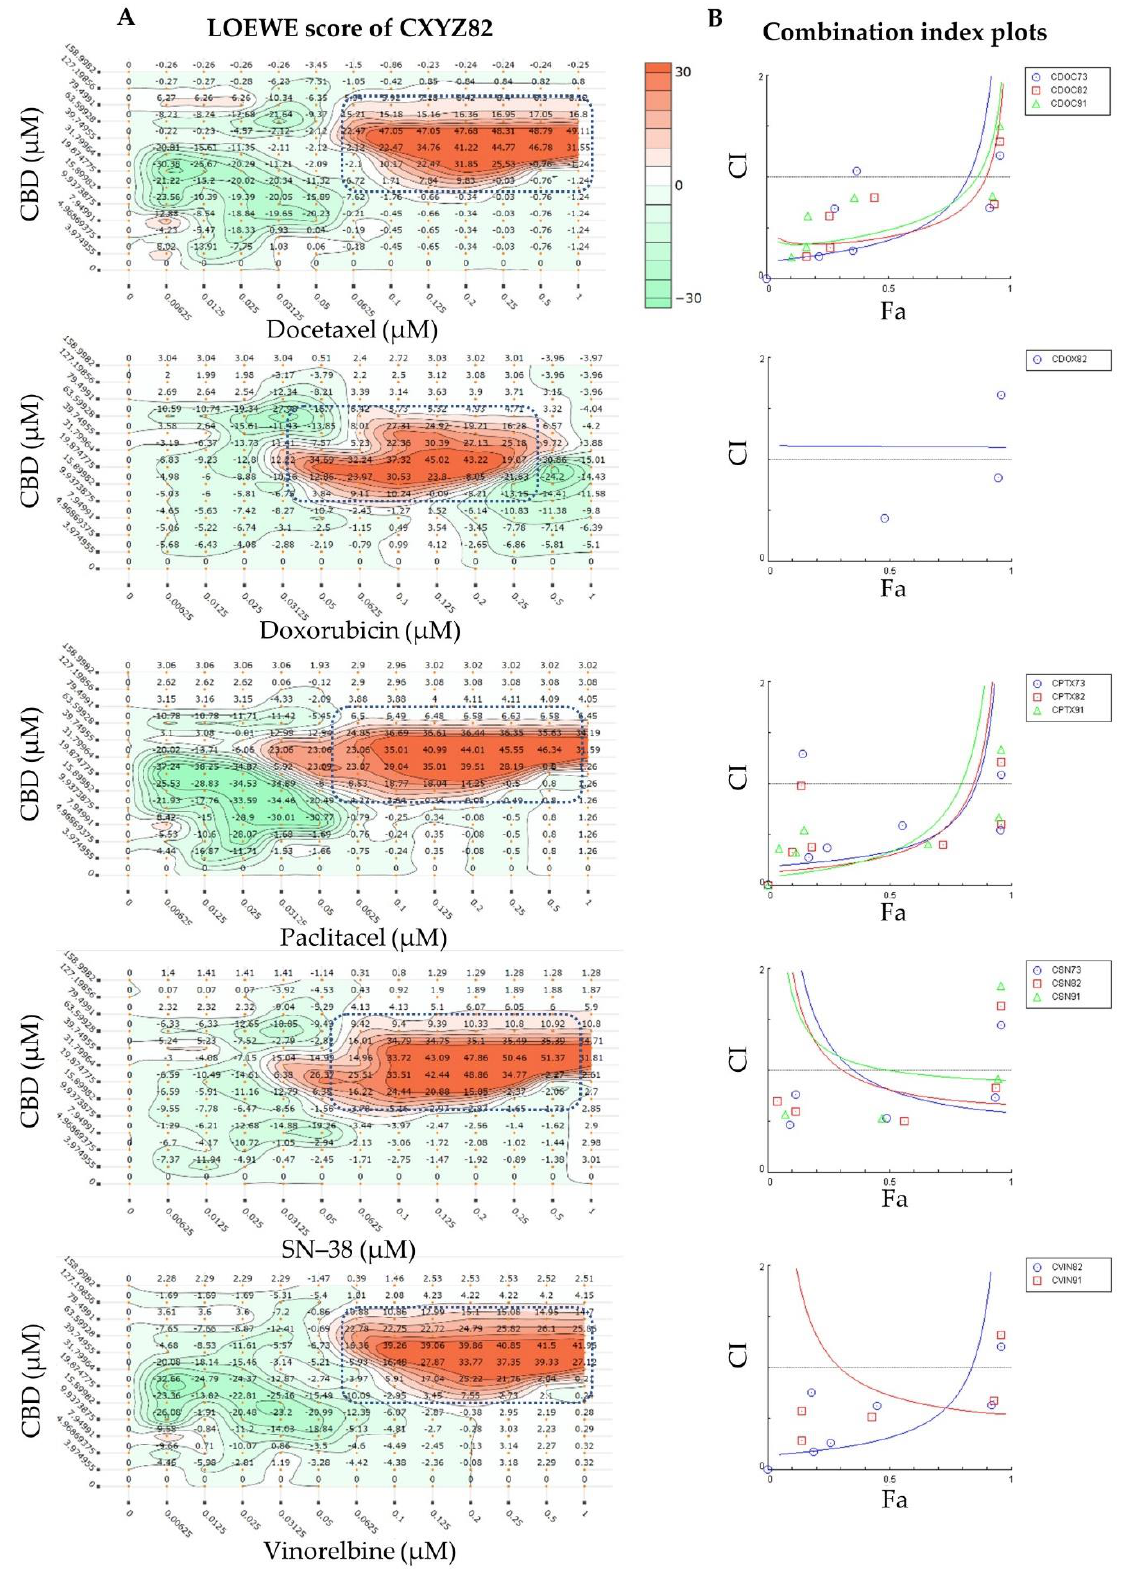
Figure 2. Most synergistic chemotherapeutic cannabidiol (CBD) combinations against MCF7 cells: ( A ) Loewe synergy quantitation of selected synergistic CBD combinations with standard chemotherapeutic agents (molar ratio of 636:1). ( B ) Combination index plots of the most synergistic combinations. Fa = fraction affected (% cell growth inhibition, where 1 = 100%).